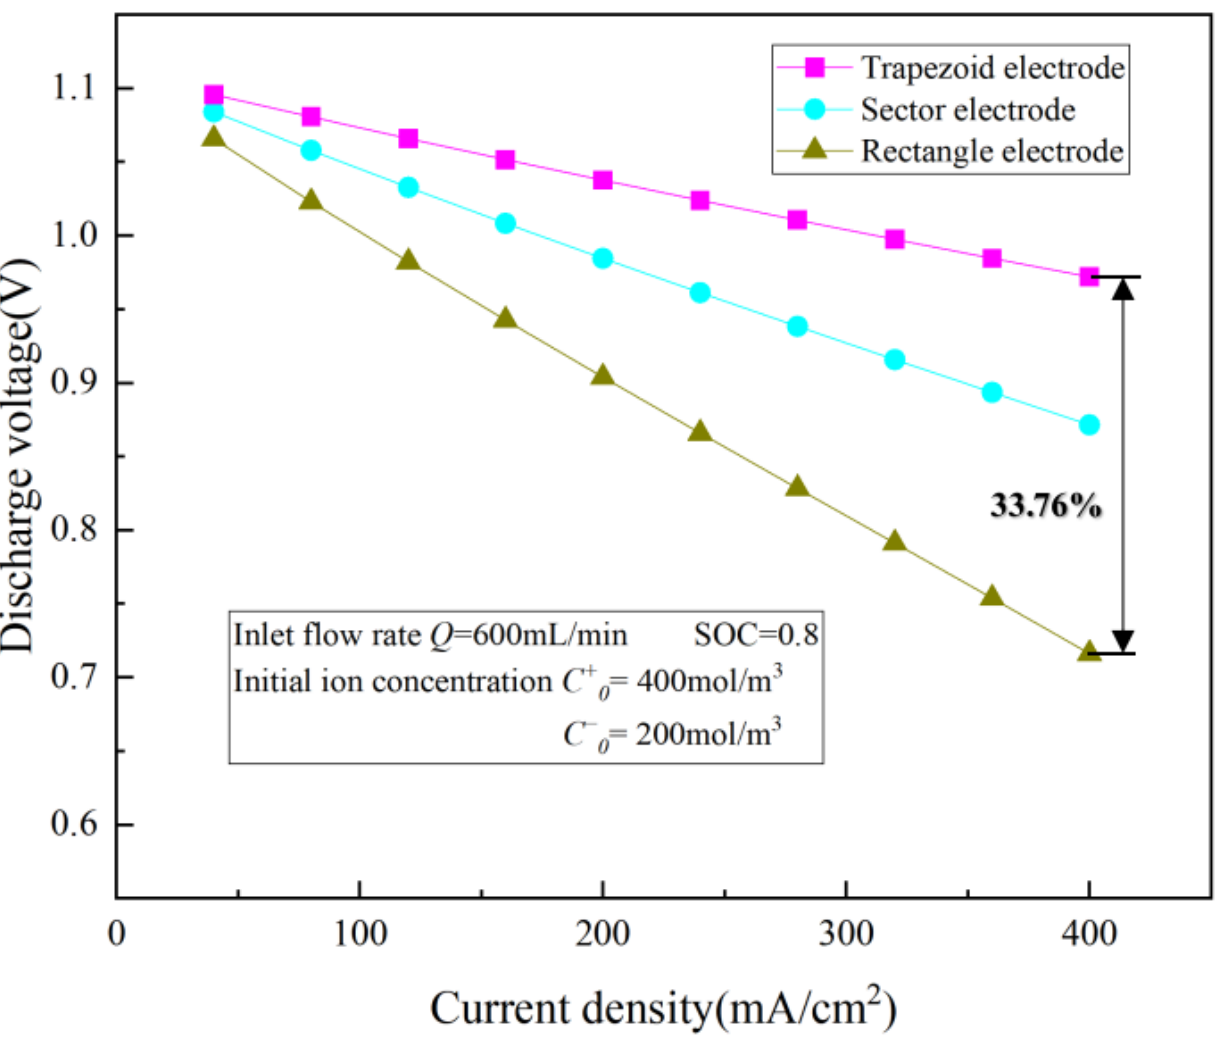
Figure 5. Polarization curve of different flow fields.